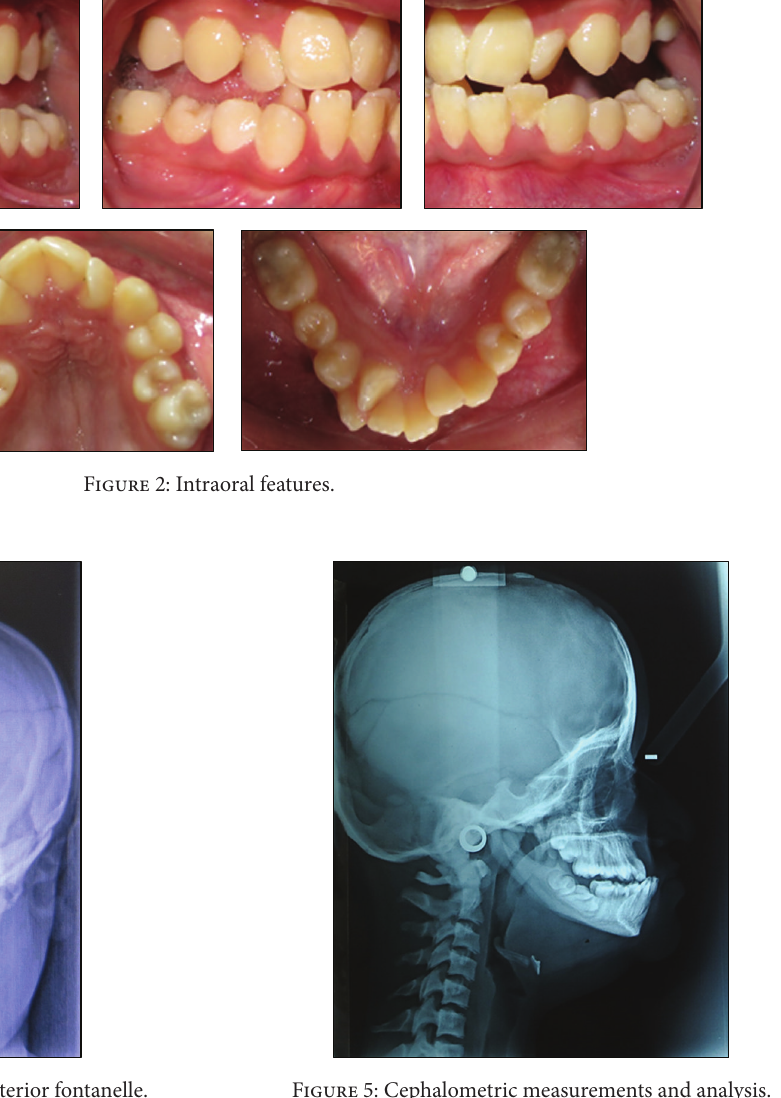
Figure 3: Skull radiograph with patent anterior fontanelle.